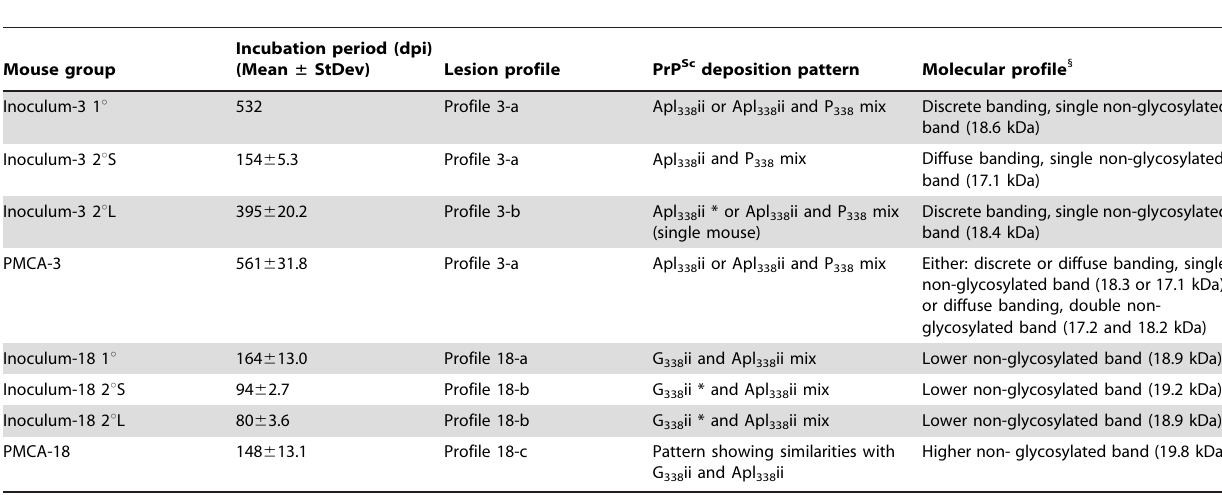
Table 1. Summary table of results for mice challenged with non-amplified and PMCA amplified inoculum-3 and inoculum-18.